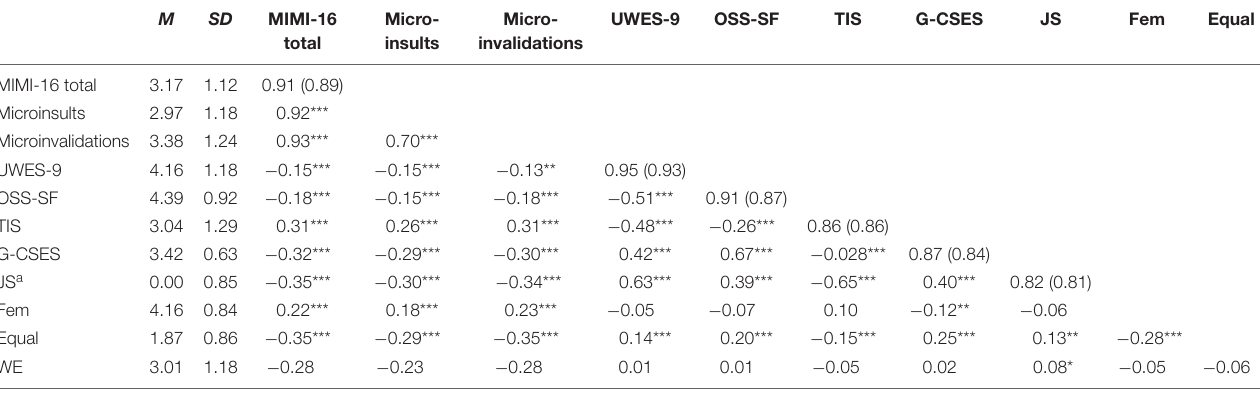
TABLE 3 | Descriptives and inter-correlations for study 2.